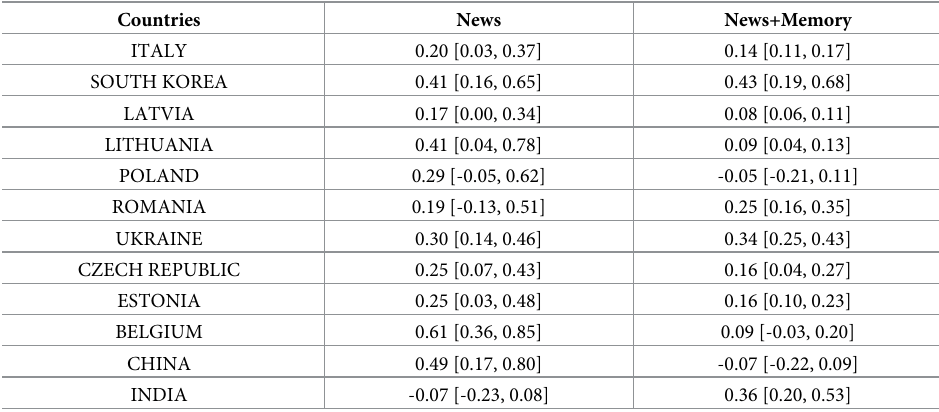
The coefficients are all significant with p < 0 . 001 , except for Poland ( p = 0 . 009 ), Romania ( p = 0 . 013 ), Belgium ( p = 0 . 003 ), and China ( p = 0 . 02